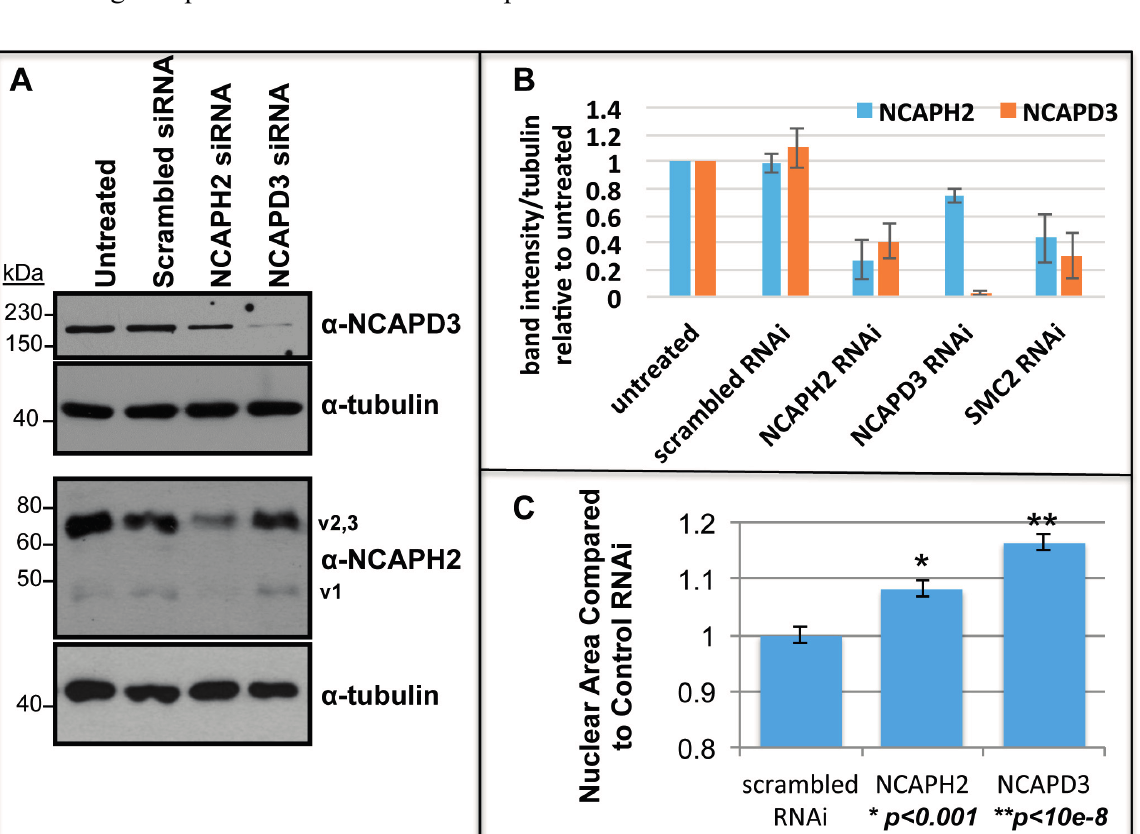
endogenous NCAPD3. Cells in bottom panels were co-transfected with splice variant 1